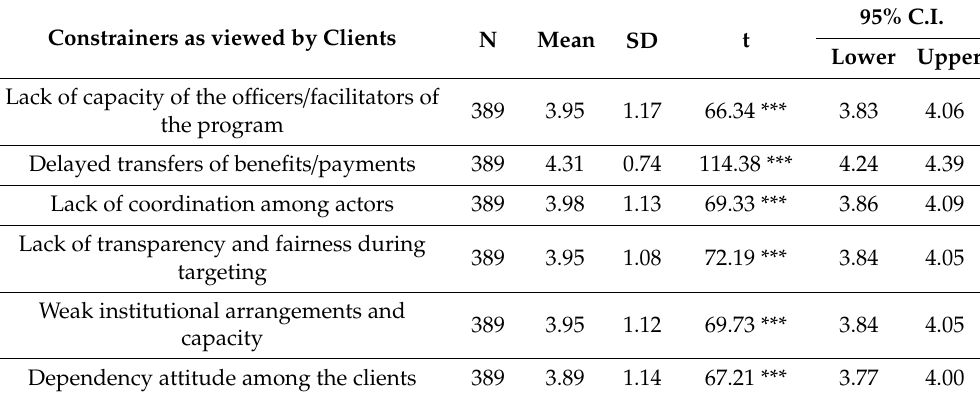
Table 3. Public Works Clients’ View of Constrainers of E ff ective Service